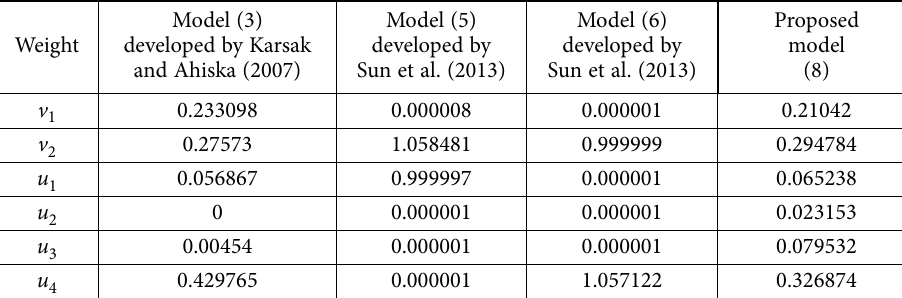
Table 5. Comparative evaluation of input and output weights